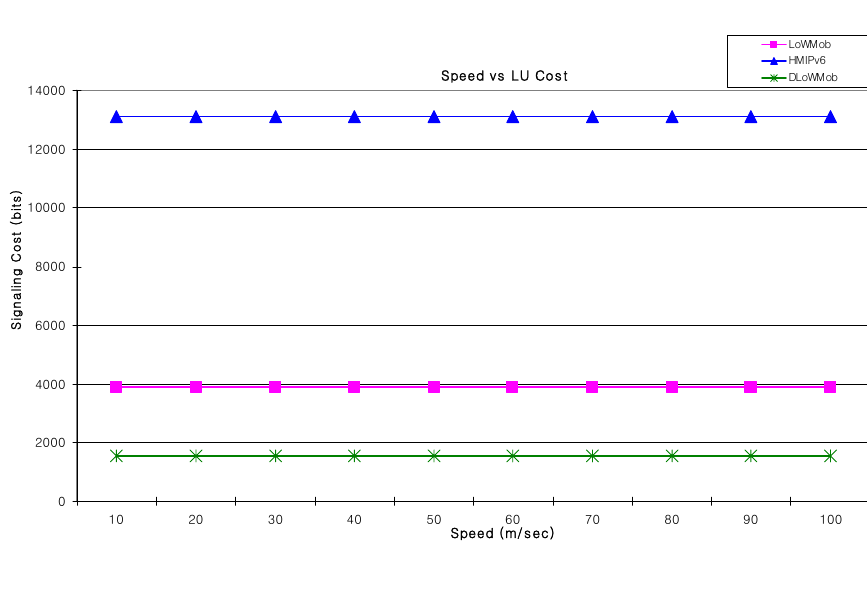
Figure 23. Speed vs. LU cost.